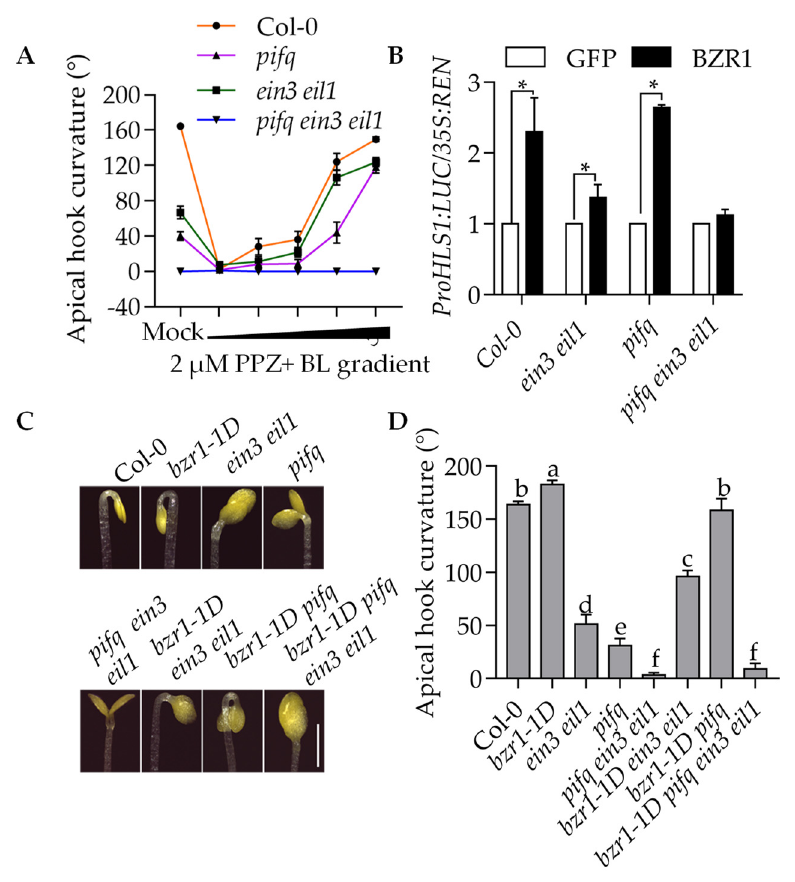
Figure 6. BR and activated BZR1 promotion of hook development require at least one class of transcription factor EIN3/EIL1 or PIFs. ( A ) BR promoted the hook development in pifq and ein3 eil1 , but not in pifq ein3 eil1 . Seedlings of Col-0, eni3 eil1 , pifq and pifq ein3 eil1 were grown on the 1 / 2 MS medium with or without 2 µ M PPZ and different concentrations of BL in the dark for 4 days. The values shown indicated means ± se; n ≥ 15. ( B ) Transient reporter gene assays show that the promoting effects of BZR1 on the expression of HLS1 requiring at least one type of transcription factors EIN3/EIL1 or PIFs. The HLS1 promoter fused to the luciferase reporter gene was co-transfected with pro35S:GFP and pro35S:BZR1-GFP into mesophyll protoplast of wild-type plants, ein3 eil1 , pifq , and pifq ein3 eil1 . The LUC activity was normalized to REN. Error bars represent standard errors of three biological repeats. * Denotes p < 0.05, as determined by a Student’s t -test. ( C , D ) The gain-of-function